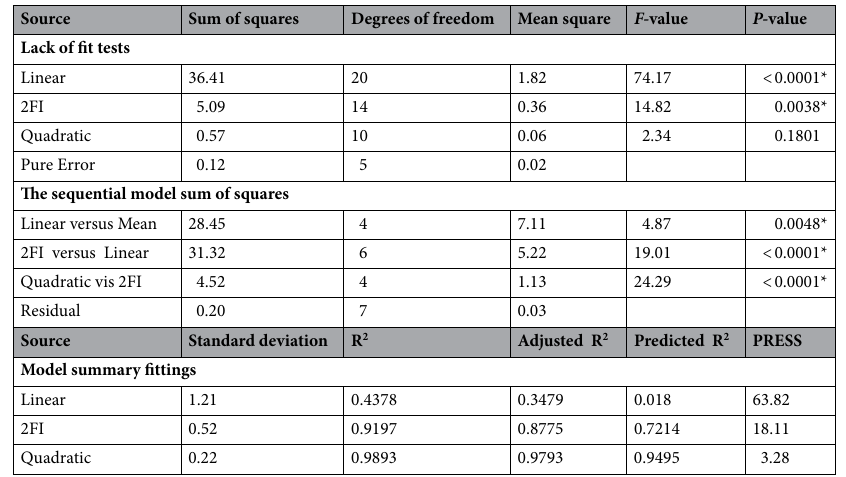
Table 3. Fitting’s summary of face-cantered central composite design based on the experimental data. *Significant values, R 2 : coefficient of determination, PRESS: prediction error sum of squares, 2FI: two factors interaction.